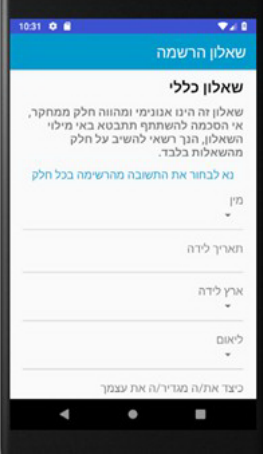
Figure 7. Registration questionnaire screen for the patient: general.